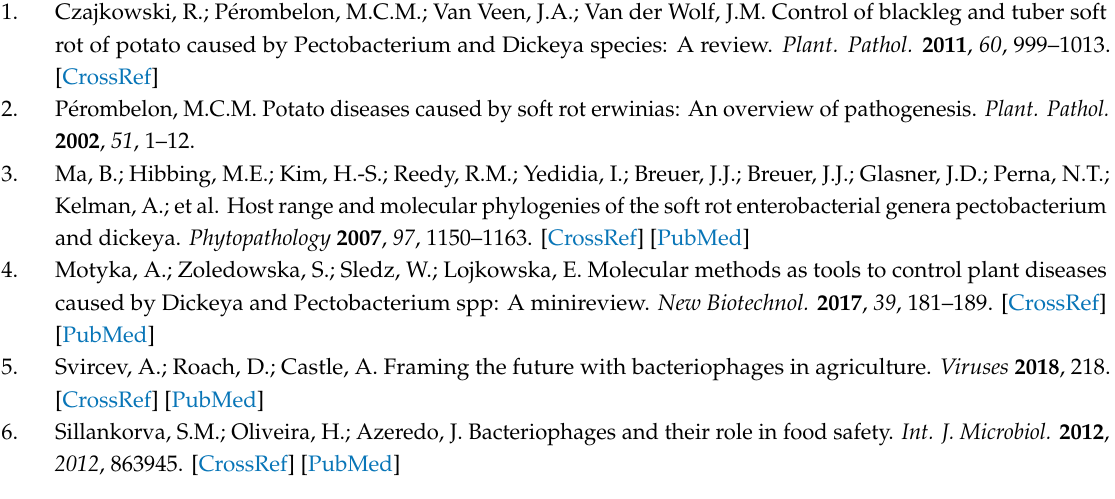
Figure S1: Proteomic tree of 447 Podovoridae and Autographiviridae phage genomes constructed using ViPTree. Figure S2: Alignment of secondary structures of phage tail spike proteins and SGNH-hydrolase made with UCSF Chimera, and possible active centre and conserved residues (circled with red) found by comparison with published structures. Figure S3: 3D structures of tail spike and tail fibre proteins of Pectobacterium phages Q19, Jarilo, DU_PP_II, PP47, PP81 and PPWS4 obtained by homology modelling and MAFFT alignment of primary sequences of tail spike and tail fibre proteins, and distance matrix for the proteins. Jarilo and DU_PP_II are suggested to be the closest relatives of Q19, and phages PP47, PP81 and PPWS4 are the members of the Pektosvirus genus. The models are colored based on a rainbow gradient scheme, where the N-terminus of the polypeptide chain is coloured blue and the C-terminus is colored red. Table S1: Infectious range of Pectobacterium phages PP47, PP81 and Q19. Table S2: Average nucleotide identity (ANI) between Pectobacterium phage PP47 and all Autographiviridae phage genomes deposited in the NCBI GenBank (threshold 0.5). Table S3: Average nucleotide identity (ANI) between and all Autographiviridae phage genomes deposited in the NCBI GenBank (threshold 0.5). Table S4: Average nucleotide identity (ANI) between Pectobacterium phage Q19 and all Autographiviridae phage genomes deposited in the NCBI GenBank (threshold 0.5). Table S5: The results of the BLAST examination of Q19 and PP47 gene products using the Genbank phage database (Bit-score > 40). Table S6: Functional assignments of Pectobacterium phage PP47 genes. Table S7: Functional assignments of Pectobacterium phage PP81 genes. Table S8: Functional assignments of Pectobacterium phage Q19